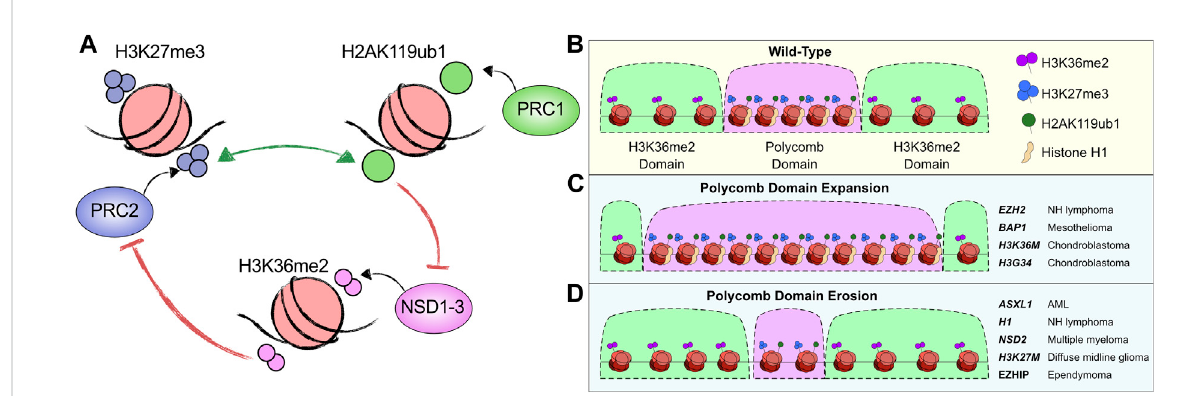
FIGURE 5 Dysregulated PcG domain formation in cancer. (A) Depiction of the protagonistic and antagonistic relationships between the histone modi fi cations H3K27me3, H2AK119ub1 and H3K36me2 and the enzymatic complexes that catalyse them. (B) Schematic of Polycomb domains (B compartments) enriched in blanket levels of H3K27me3, H2AK119ub1 and occupied by Histone H1. These domains are boundaried by ‘ A ’ compartment related H3K36me2 enriched domains. (C) Illustration of how different mutations in PcG and other epigenetic machinery causes Polycomb domain expansion. The genes mutated and the cancer they are associated with are listed on the right. (D) Illustration of how different mutationsinPcGandotherepigeneticmachinerycausesPolycombdomainerosion.Thegenesmutatedandthecancertheyareassociatedwithare listed on the